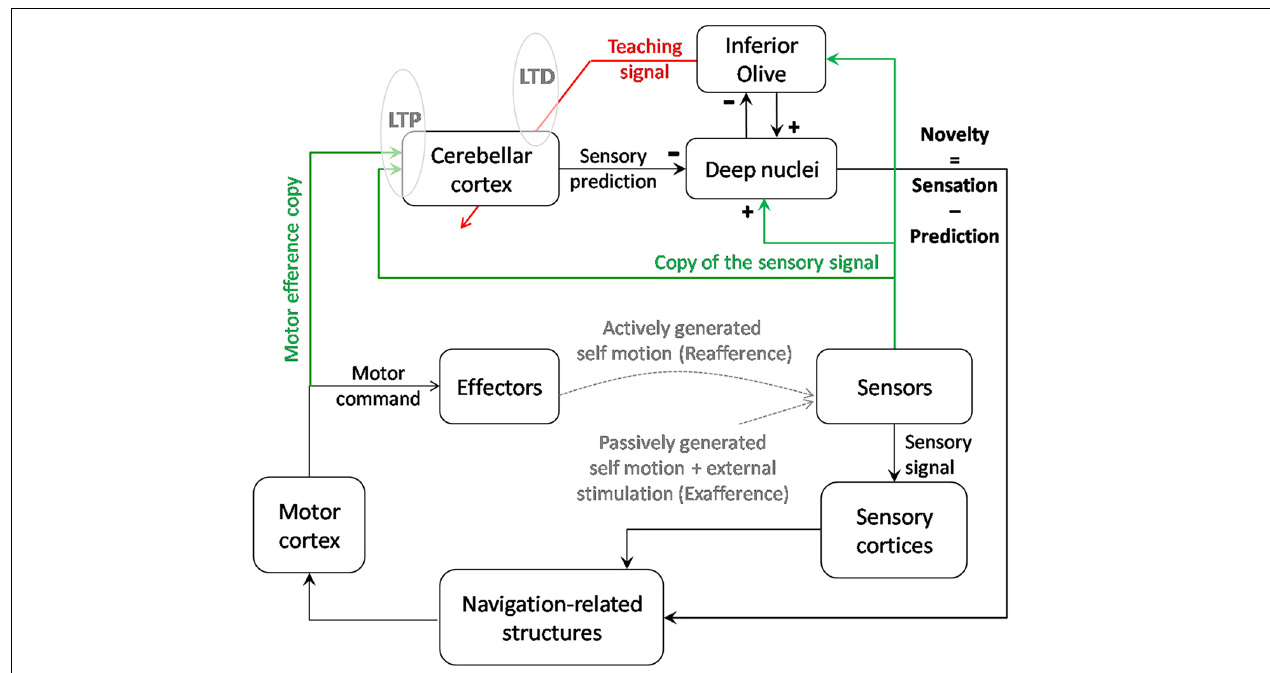
FIGURE 4 | Contribution of cerebellar computation to navigation. Cerebellar cortex as an adaptive filter could transform an input signal consisting of self-motion sensory signals and a motor efference copy into a prediction of the sensory signal expected from voluntary movements and the previous sensory state. By comparing the sensory prediction with the actual sensory signal, the cerebellar output helps the system to detect novelty in the environment. Thanks to a parallel output sent to the inferior olive, this novelty signal is modified into a teaching signal which, if repeated in correlation with the sensory inputs, could contribute to modify the cerebellar